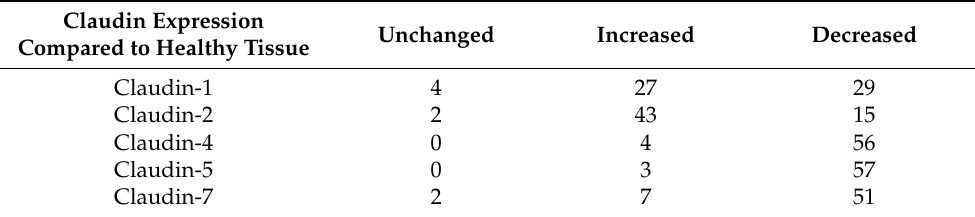
Table 1. Number of patients with unchanged, decreased, or increased claudin expression in the tumor tissue compared to the corresponding healthy oral tissue. A claudin signal in the tumor tissue of between 95 and 105% in the healthy tissue is defined as unchanged. Claudin Expression Compared to Healthy